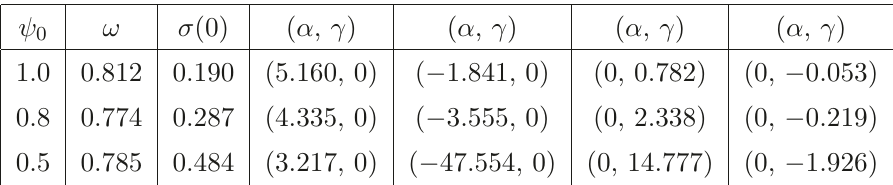
Table 1 . Values of ψ 0 , frequency ω and σ (0), i.e. the value of the metric function σ ( r ) at the origin, of the background boson star solution and values of ( α , γ = 0) and ( α = 0, γ ), respectively, for which non-trivial solutions without nodes ( k = 0) of (3.4)